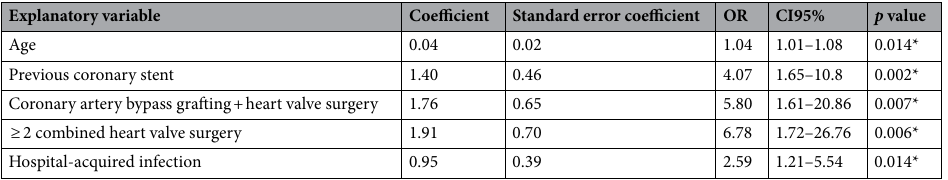
Table 1. Multiple regression model. CI confidence interval; * p value < 0.05.